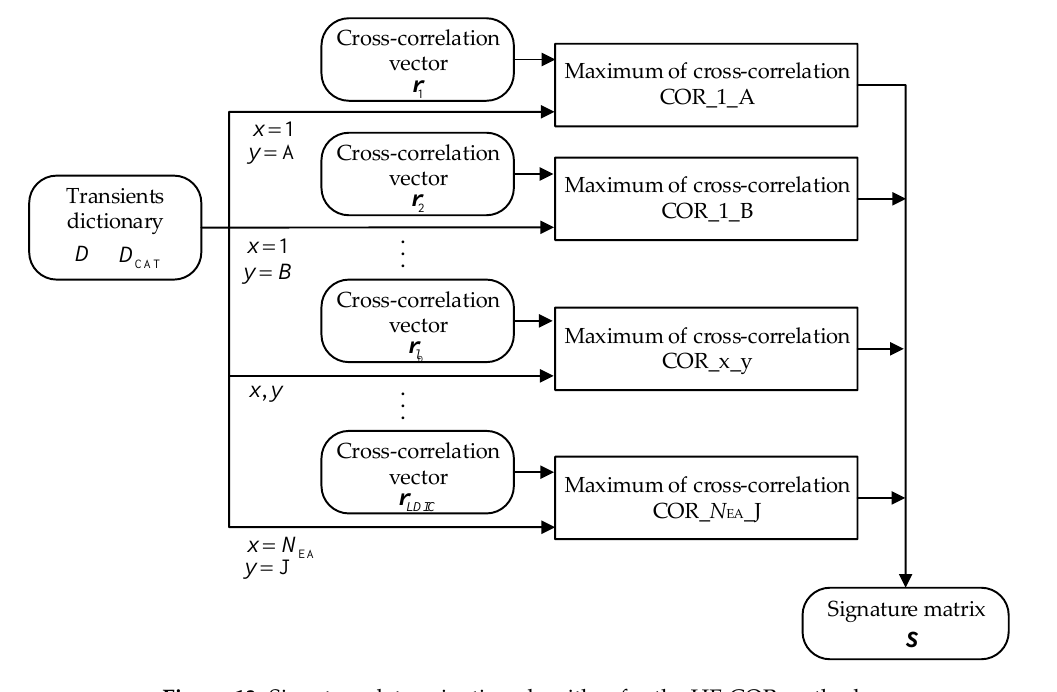
Figure 13. Signature determination algorithm for the HF-COR method.